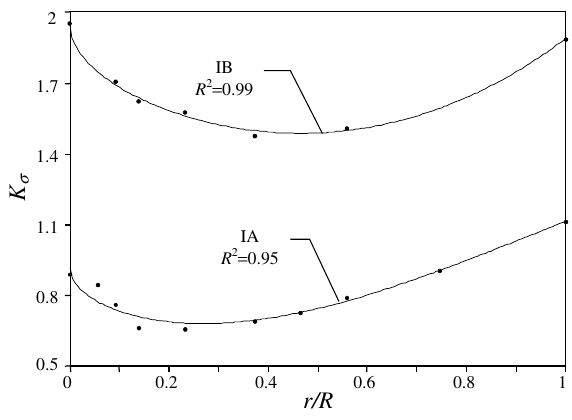
Fig 5. Relationship of stress concentration factor K σ with respect to ratio r / R ; R 2 is determination